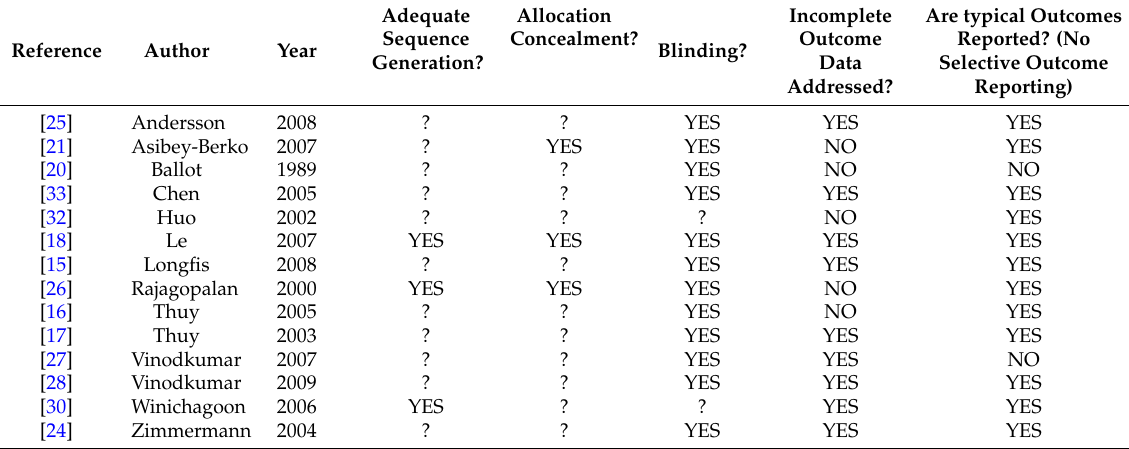
Table 3. Risk of bias summary table of all 14 included RCT. Assessment categories: YES: criterion fulfilled; NO: criterion not fulfilled; “?”: unclear, not enough information